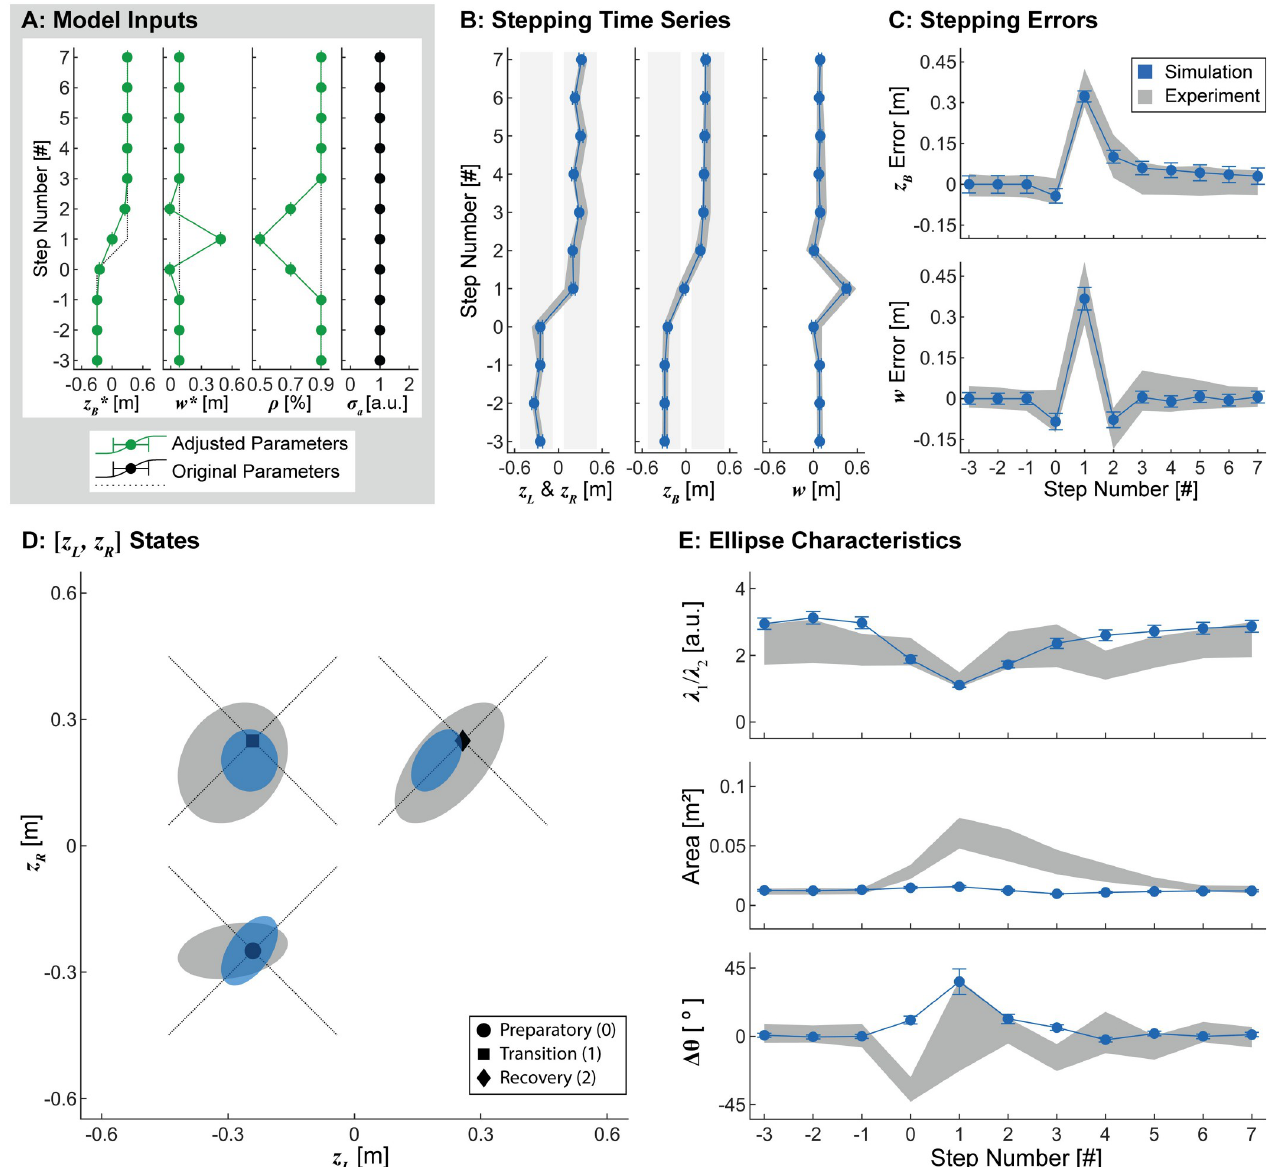
Fig 7. Adaptive Control Proportion. A) Model parameters. Here, in addition to adapting the stepping goals ([ z B � , w � ]; Fig 6), the control proportion ( ρ ) was also varied during the preparatory, transition, and recovery steps to reflect the hypothesized maneuverability and error correction at each step. Additive noise ( σ a ) remained unchanged from the original, constant parameter model. B-E) Results obtained from 1000 simulated lateral transitions using the parameters in (A), with data plotted in an identical manner to Fig 6B–6E. Adding step-to-step modulation of ρ again captured experimental stepping time series and errors at each step (B-C). Here however, allowing ρ to adapt at each step also induced changes in prediction ellipse aspect ratios during the transition steps that were qualitatively similar to those observed experimentally. Modulating ρ however, did not induce corresponding changes in ellipse area (D-E). Thus, adapting ρ at each step is also necessary but not sufficient to emulate human stepping during lateral